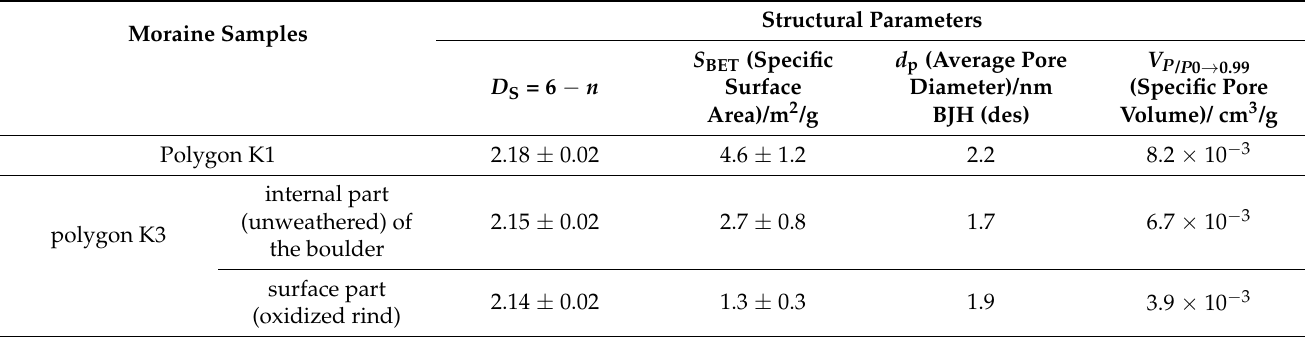
Table 1. Parameters of the mesostructure of the moraine samples obtained from the analysis of SANS ( D S = 6 − n ) and low-temperature nitrogen absorption data ( S BET, d p, and V P / P 0 → 0.99